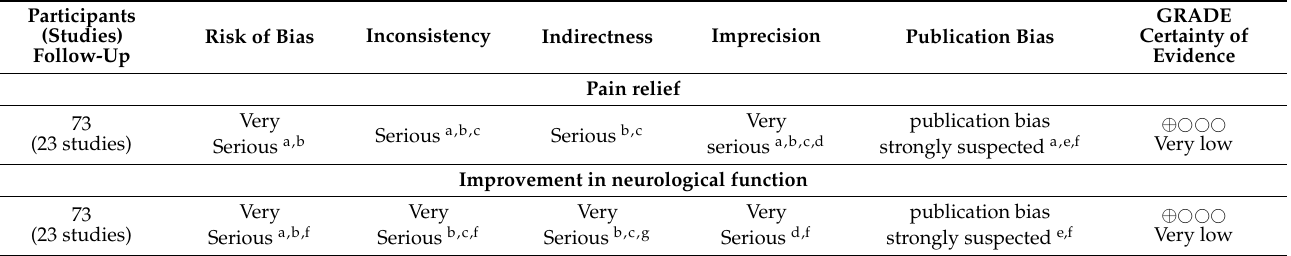
Table 2. Evidence Profile Table. Evidence profile table evaluating domains per the Grading of Recommendations, Assessment, Development, and Evaluations (GRADE) criteria are displayed.